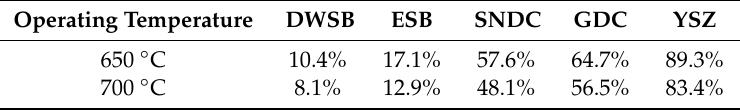
Table 3. The proportion of electrical resistances for di ff erent